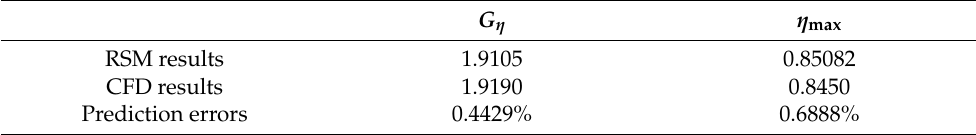
Table 6. Comparison of CFD simulation and two-objective optimization results.